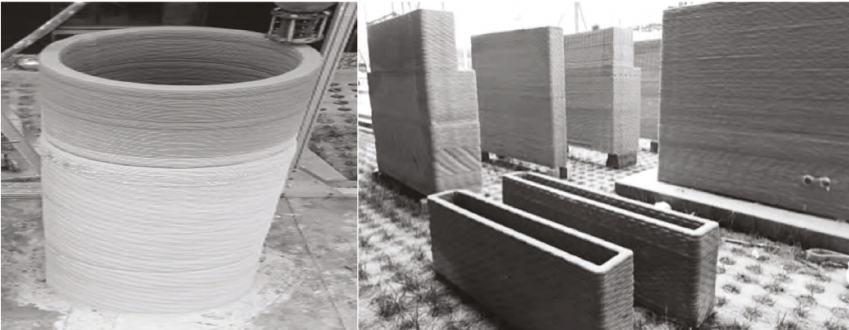
Figure 29: Concrete 3D printing wall and column [59].